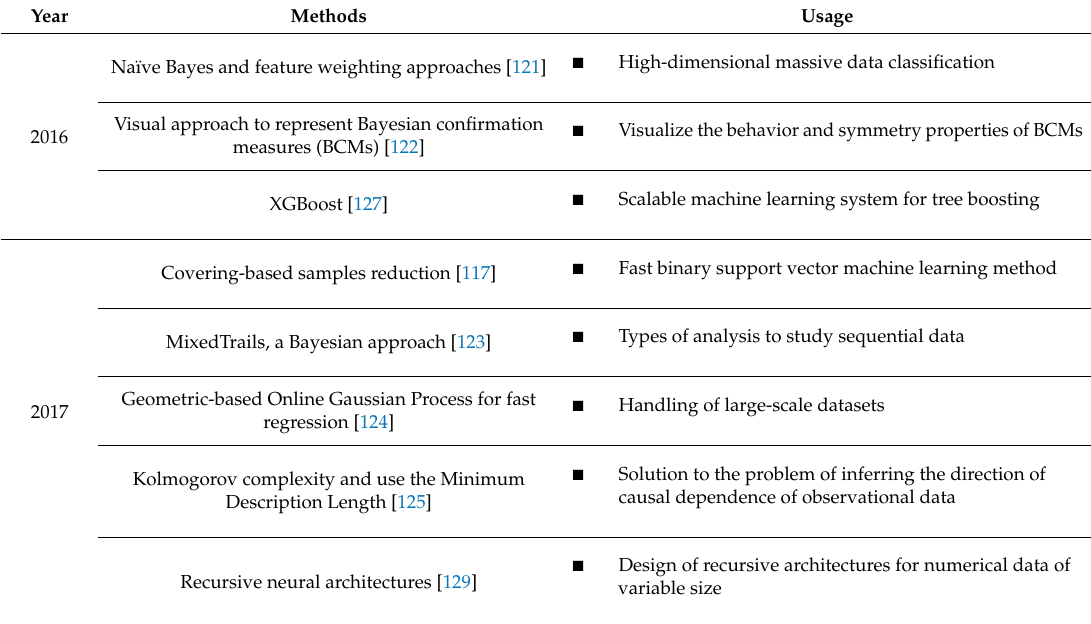
Table 4. Recent methods for general